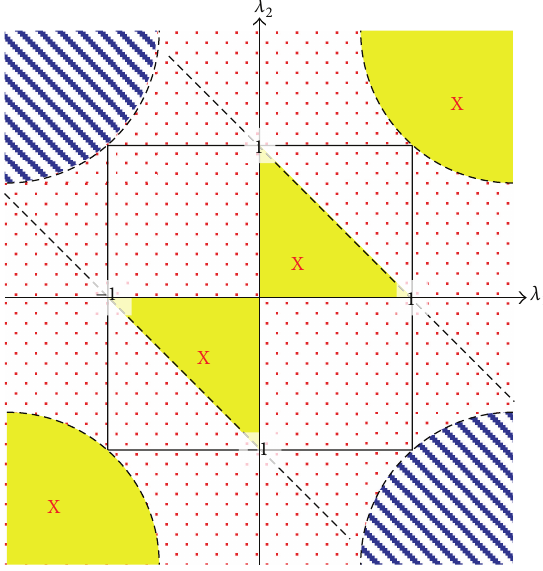
Figure 1: Regions of the 𝜆 1 - 𝜆 2 space: explored and unexplored. condition 𝜆 1 𝜆 2 > 1 requires either 𝛼 > 1 or 𝛽 > 1 , which is not acceptable. As a result, we have explored the following regions of the 𝜆 1 - 𝜆 2 space in Figure 1. The shaded regions with “ 𝑋 ” mark are the subsets whose (𝜆 1 , 𝜆 2 ) -tuples cannot be realized in our model. The two hatched regions depict